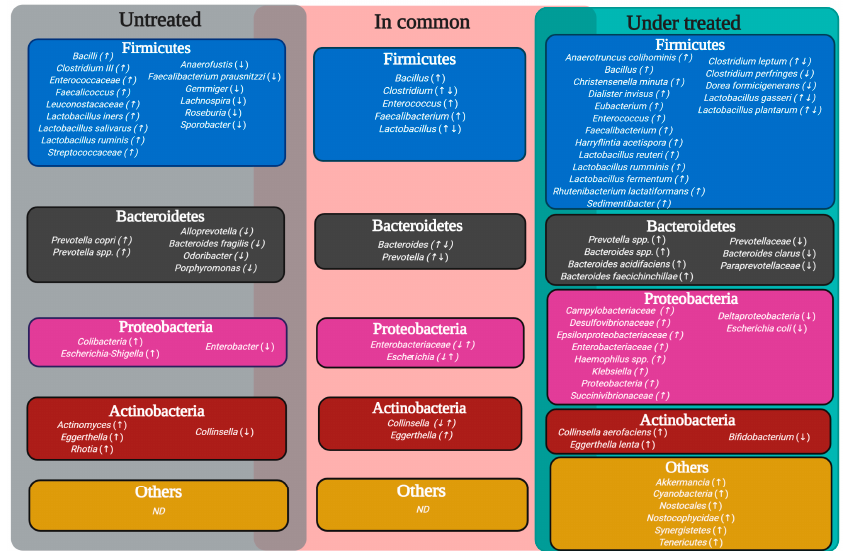
Figure 2. Variability in the gut microbiota in RA under treated and untreated with DMARDs. Genera colors represent phylum and ↑ / ↓ , increased / decreased status in patients with rheumatoid arthritis untreated or under treated. DMARDs, disease-modifying antirheumatic drugs; RA, rheumatoid arthritis; ND, non-describable.